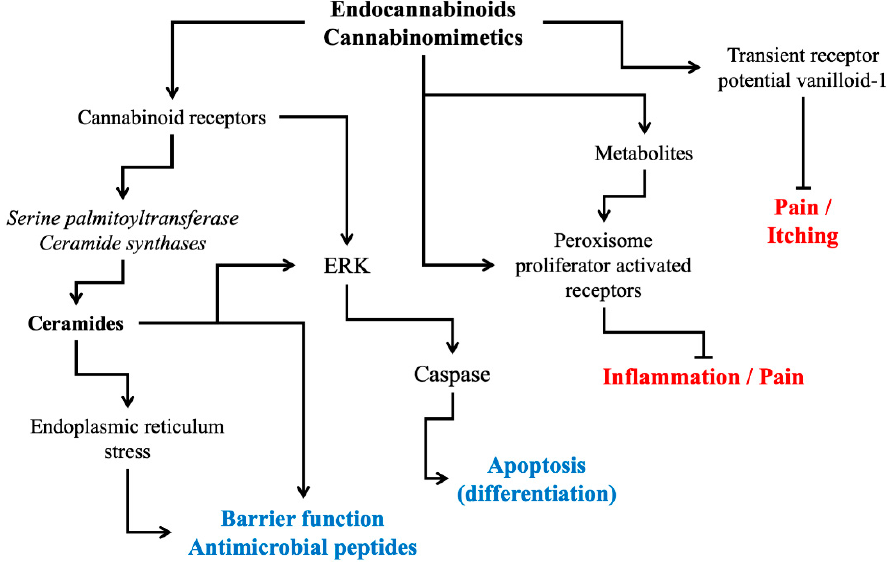
Figure 2. Effects of cannabinoid receptor 1/cannabinoid receptor 2 (CBR1/CBR2) on skin barrier